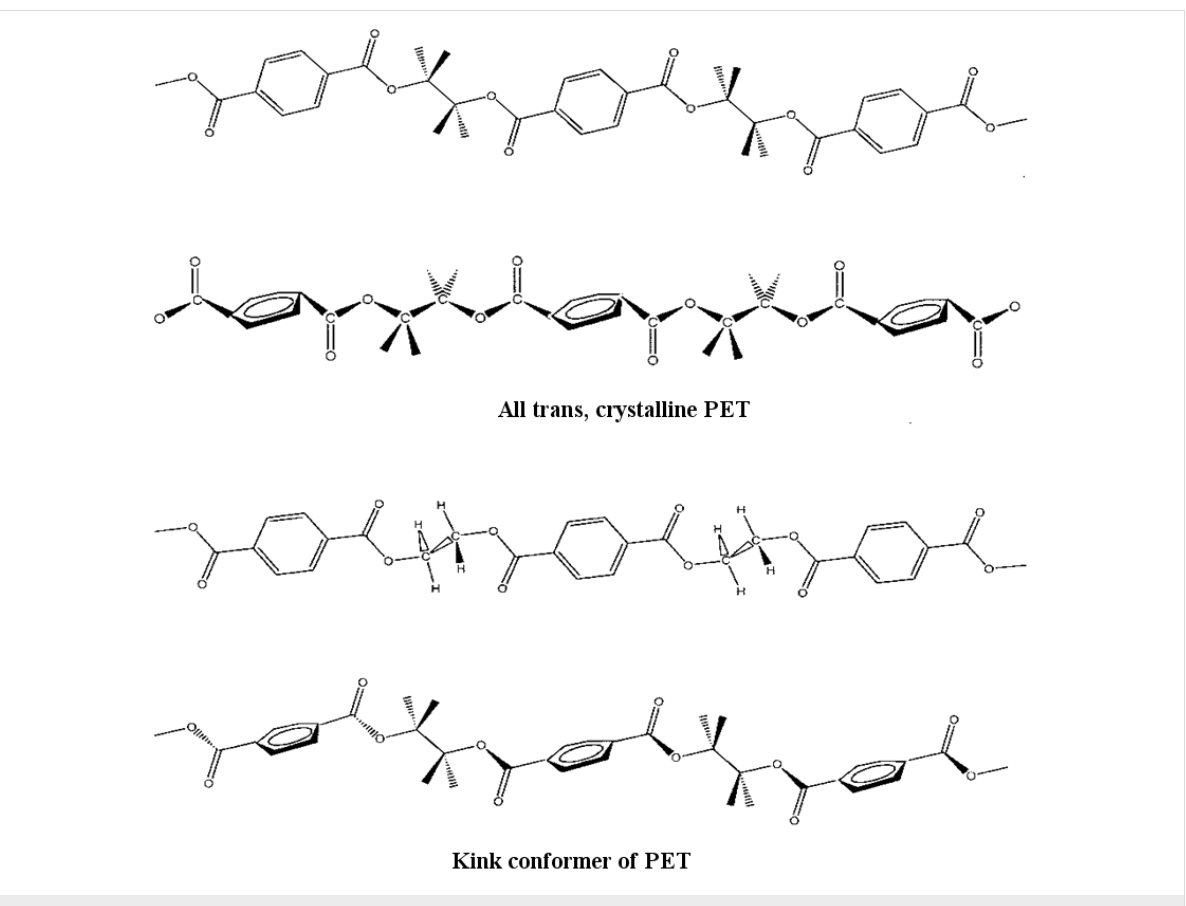
Figure 11: Crystalline all trans ( t ) and γ -CD-included g±tg conformations of PET